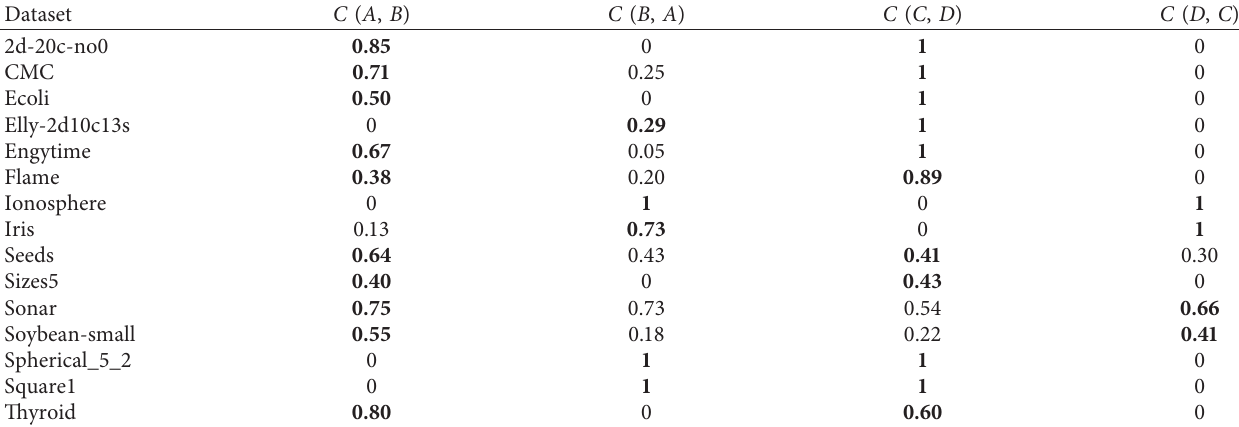
Table 3: The coverage metric of the obtained Pareto-fronts by the competing algorithms from the combined pool of sets.